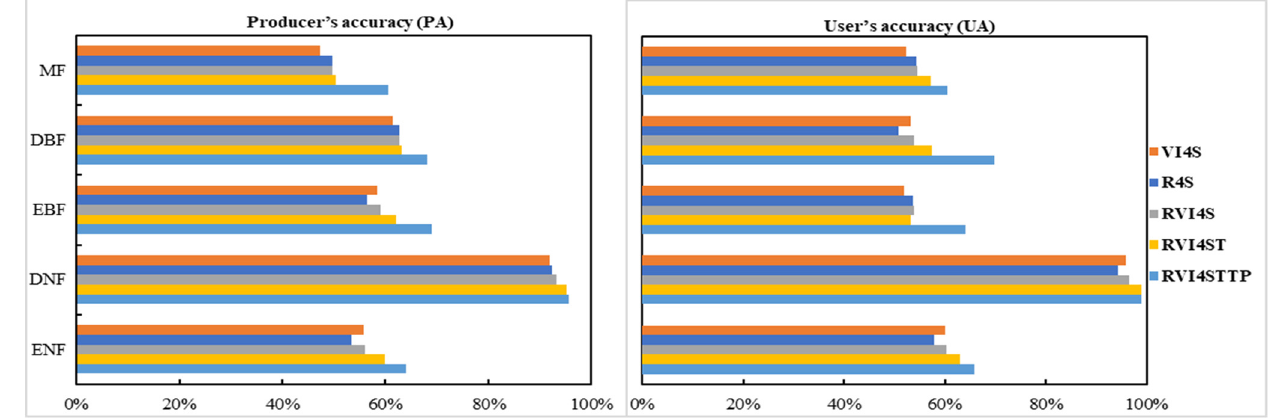
Figure 12. The PA and UA comparison of multi-seasonal composite images with spectral reflectance, VI, and the combination of spectral reflectance and VI, respectively.